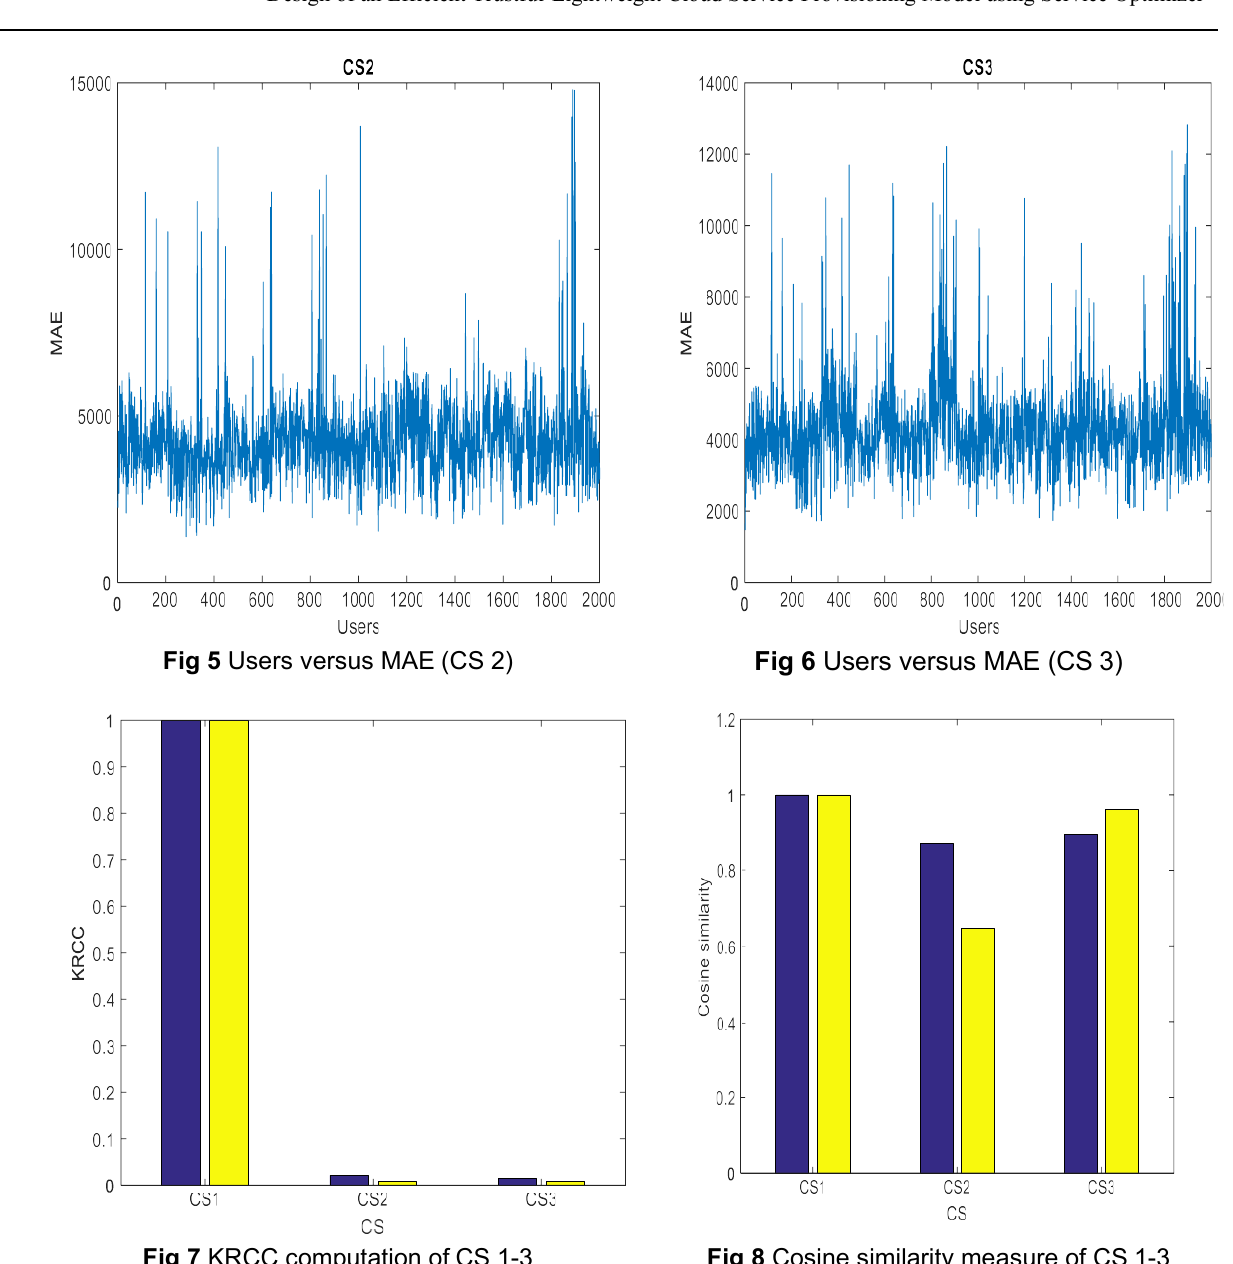
Fig 7 KRCC computation of CS 1-3 Fig 8 Cosine similarity measure of CS